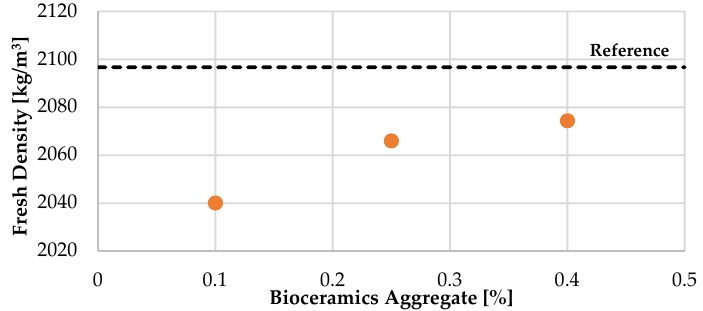
Figure 7. Fresh state bulk density results for cement mortars.